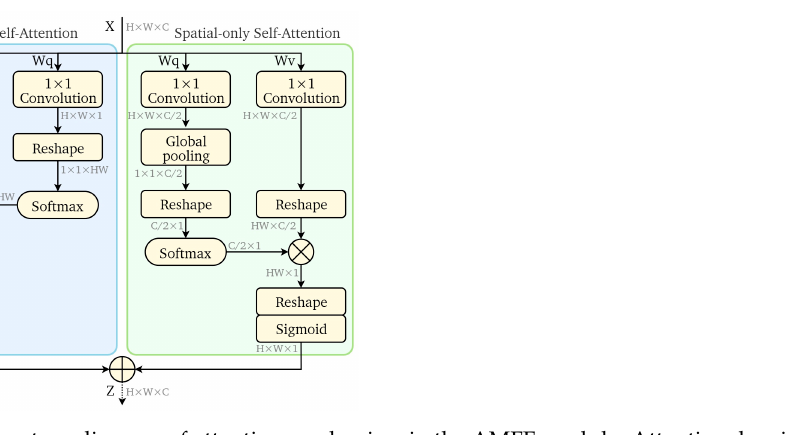
Figure 3. Structure diagram of attention mechanism in the AMFF module. Attentional weights are calculated at the channel and spatial dimensions.